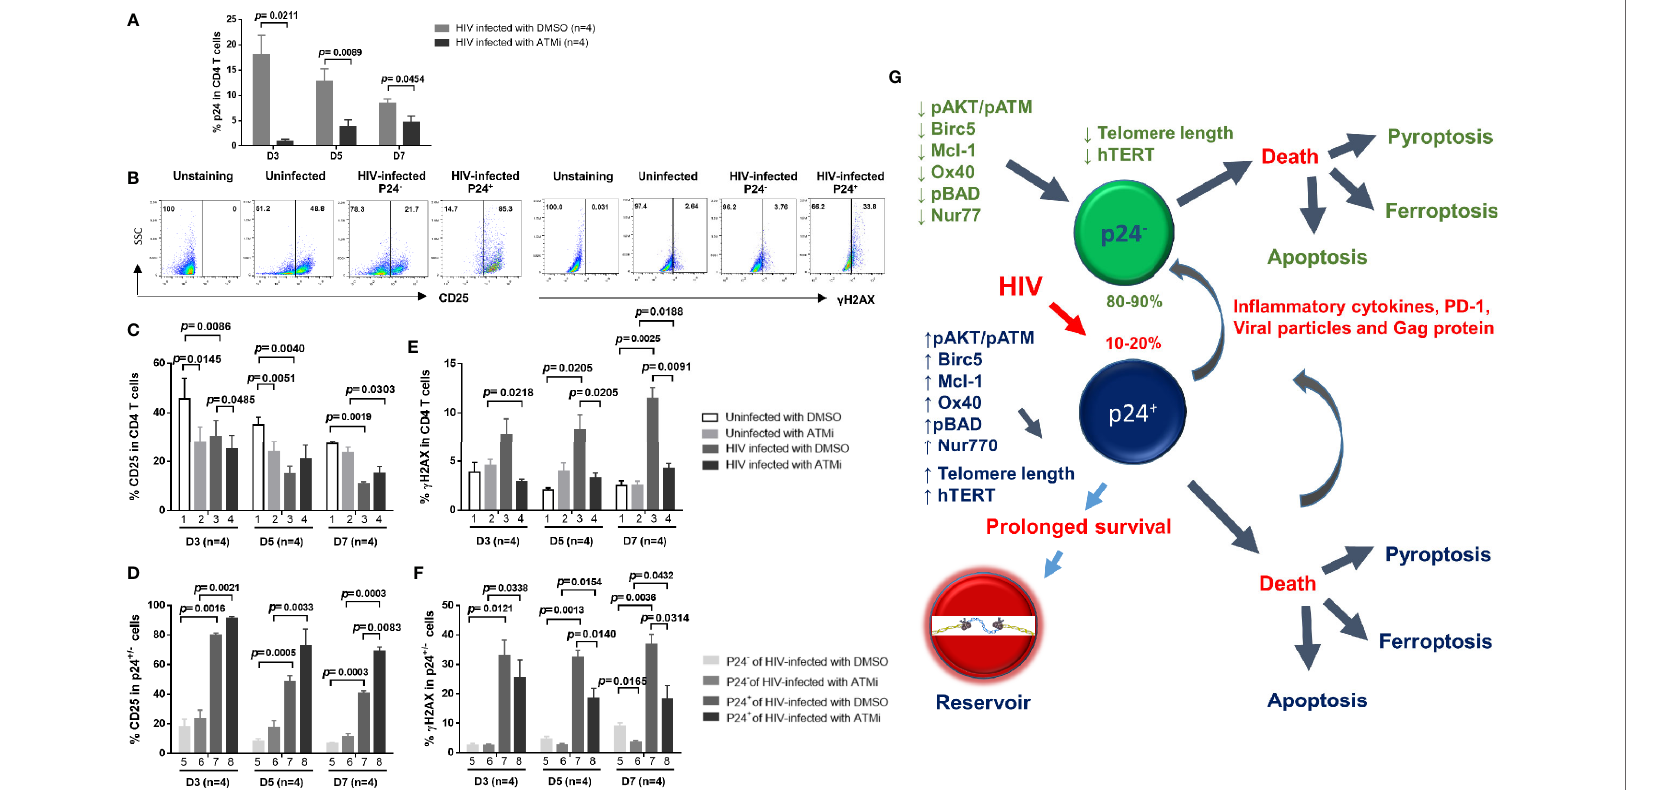
FIGURE 7 | Blockade of ATM promotes HIV-infected cell survival via inhibiting T cell activation, HIV infection, and DNA damage. (A) p24 expression in HIV-infected CD4 T cells treated with DMSO or ATM inhibitor (ATMi). (B – F) Summary data of the % of CD25 and g H2AX expressions in uninfected and HIV-infected (p24 + and p24 - ) CD4 T cells treated with DMSO or ATMi for 3, 5, and 7 days. (G) A schematic model of the fate of productively infected CD4 T cells and bystander cells during early HIV infection. HIV promotes CD4 T cell death through enhancing various programmed cell death pathways, including apoptosis and pyroptosis (especially in p24 + cells) or ferroptosis (especially in p24 - cells) during early viral infection. Mechanistically, HIV infection promotes secretion of in fl ammatory cytokines as well as viral particles and proteins (such as Gag) that can differentially regulate the pro- and anti-apoptotic proteins, such as Bad, pBad, Bcl-2, OX40, Nur77, Mcl-1, and Birc5, in p24 + and p24 - cells. HIV infection also dysregulates T cell receptor (TCR) signaling pathways, in particular PI3K (such as AKT/ATM) and telomerase hTERT activities, and thus affects telomere length and cell survival or death machineries in p24 + and p24 - cells. While productively infected (p24 + ) cells experience more death than p24 - bystander cells, p24 + cells appear to exhibit survival activity, thus favoring HIV reservoir formation and latency establishment. Speci fi cally, productively infected CD4 T cells show prolonged telomeres, increased levels of telomerase, and more activated TCR signaling pathways compared to bystander CD4 T cells, indicating the involvement of cell survival and pro-reservoir machineries during HIV infection. Importantly, blocking the ATM pathway promotes uninfected cell death but enhances virus-infected cell survival, and blocking HIV infection enhances overall cell survival, both through regulating the signaling pathways involved in the maintenance of genomic telomere integrity. These results indicate that HIV-infected and uninfected cells employ different mechanisms for survival and death during HIV